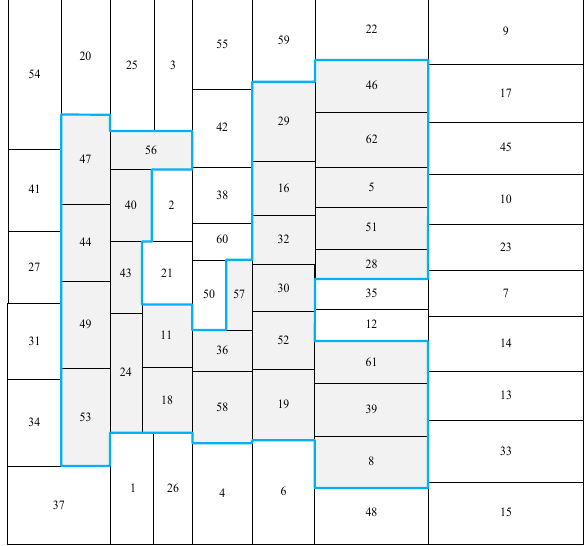
Figure 16. Layout configuration for DU62.